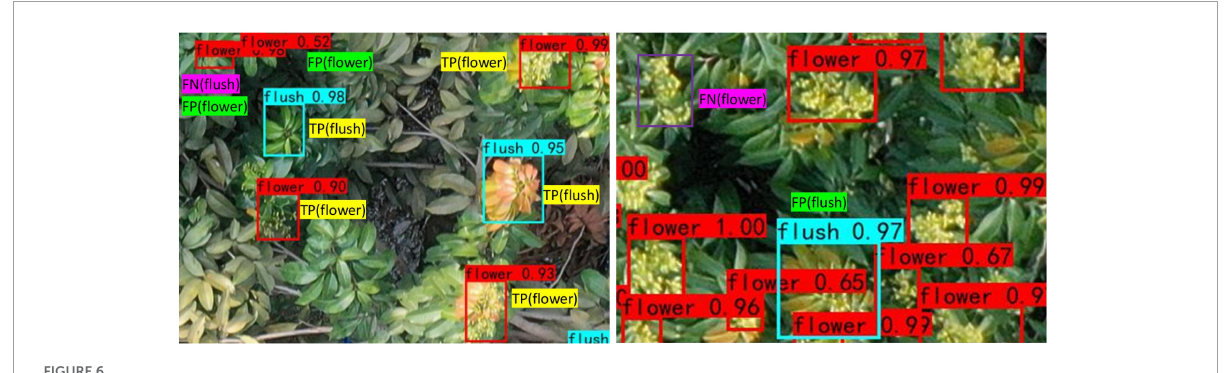
FIGURE6 TP, FP, and FN samples of flower clusters and flushes.